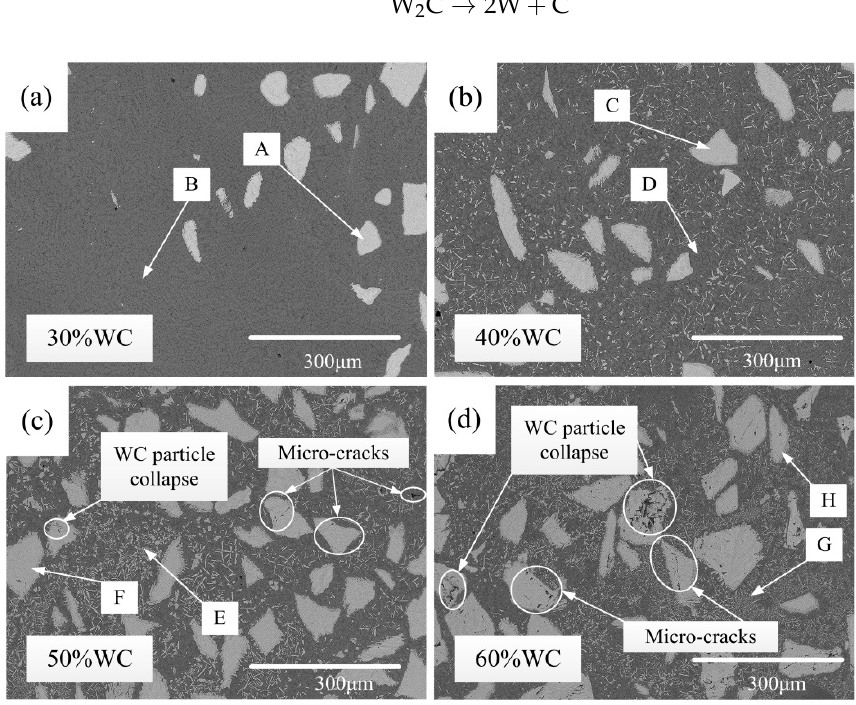
Figure 2. Surface morphologies: ( a ) 30% WC, ( b ) 40% WC, ( c ) 50% WC, and ( d ) 60% WC. When the WC content increased up to 50%, as shown in Figure 2c, the amount of bar-shaped carbides noticeably rose. In the carbide-clustered area (point E), the W content reached about 14%; that is, the precipitation of WC particles became more and more serious with the increase in the WC content. Another observation was that several cracks occurred in the 50% WC coating. The root reason for crack formation is the difference in thermophysical properties between WC particles and the binder matrix [22]. In particular, the thermal expansion coefficient of WC is 6.5–7.4 × 10 − 6 K − 1 , while this value for NiCrSiBC is 13.3–16.8 × 10 − 6 K − 1 . Meanwhile, during the cladding process, coating materials were heated and then cooled in a very short time. Therefore, in the solidification process of coating materials, the shrinkage of the binder matrix was much more significant than that of the WC particles, and therefore, WC particles were subjected to tensile stress, resulting in microcrack initiation [23]. Then, microcracks nucleated at stress concentrators, which were the WC particles, and propagated along the maximum stress direction. Meanwhile, the coatings with high content of WC were more susceptible to cracks. On the one hand, more WC particles meant more tensile stress induced inside the coating. On the other hand, in the hardening phase, more WC particles led to higher hardness but poorer ductility. In addition, the precipitated carbides have been proven to increase tensile stress and, therefore, increase crack sensitivity [10]. Thus, once tensile stress was greater than the fracture strength of the material, cracks occurred. As can be seen in Figure 2d, when the WC content reached 60%, more cracks were formed than that in the case of 50% WC. Furthermore, a few WC particles were seriously damaged besides cracking due to the further increased tensile stress coupled with the reduced fracture strength resulting from a further increase in WC particles. Cracks were more likely to occur due to greater stress in the WC with larger particle sizes [24].